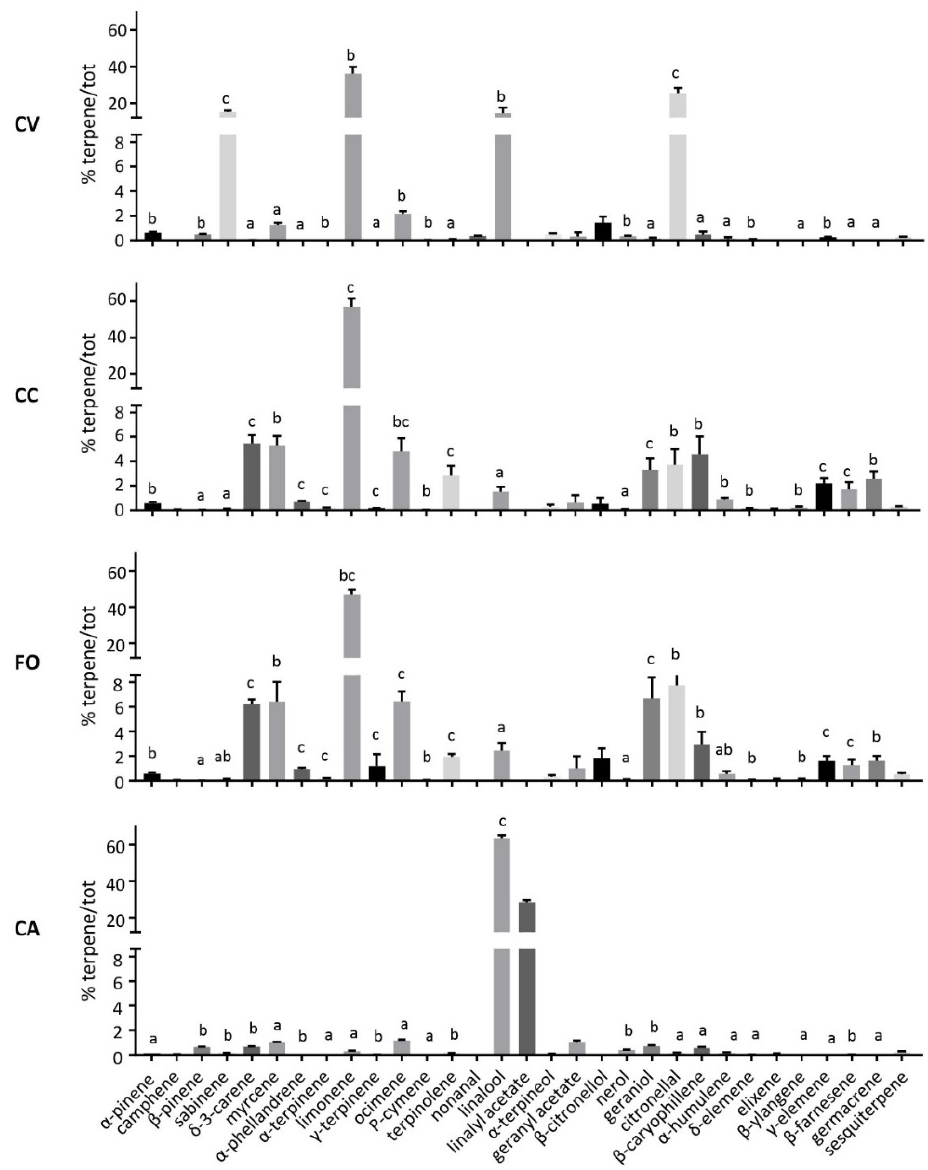
Figure 3. Percentages of the plant secondary metabolites sequestered in the leaves of Citrus volkameriana (CV), Forner-Alcaide no. 5 (FO), Carrizo citrange (CC), and Citrus aurantium (CA). Bars indicate means + standard errors. Different letters on the top of the bars indicate significant differences between the four Citrus varieties (Mann–Whitney U test).